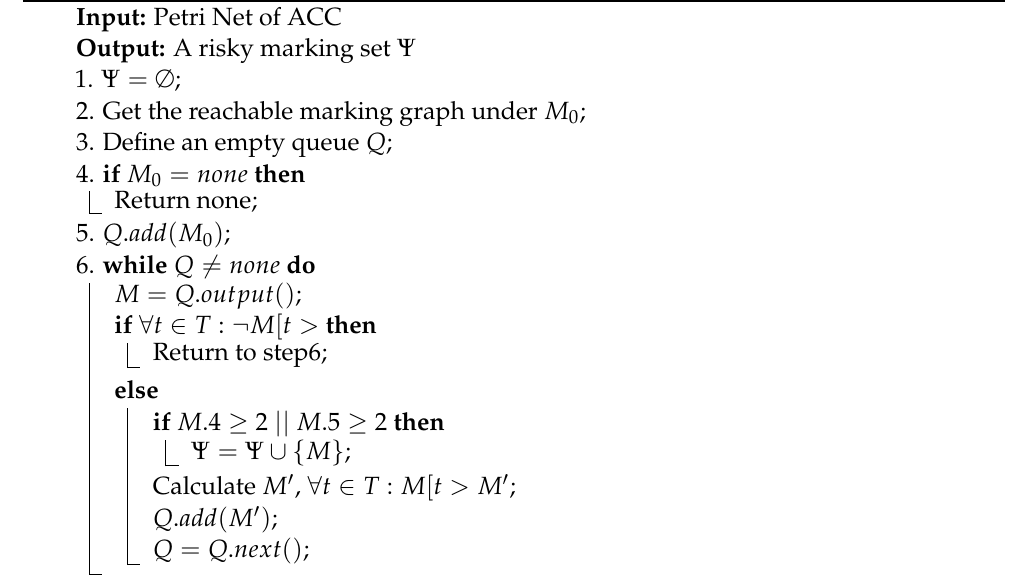
Algorithm 1: Risk of ACC Identification